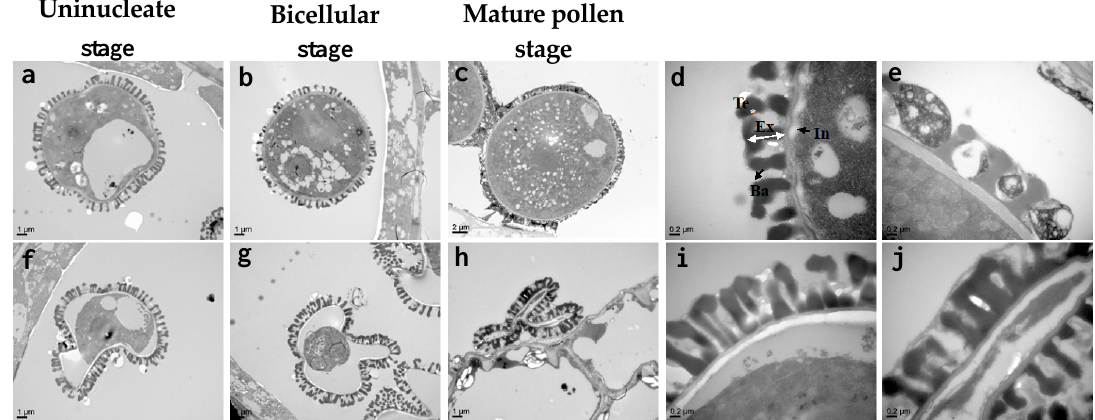
Figure 6. TEM observation of pollen grain in Bra-MIR319a overexpressing transgenic Arabidopsis . ( a – c ) Different development stages of wild-type plants and Bra-MIR319a transgenic plant pollen grains ( f – h ). ( d , e ) and ( i , j ), magnified images of ( b , c ) and ( g , h ). Te, tectum; Ba, baculum; Ex, exine; In, intine.